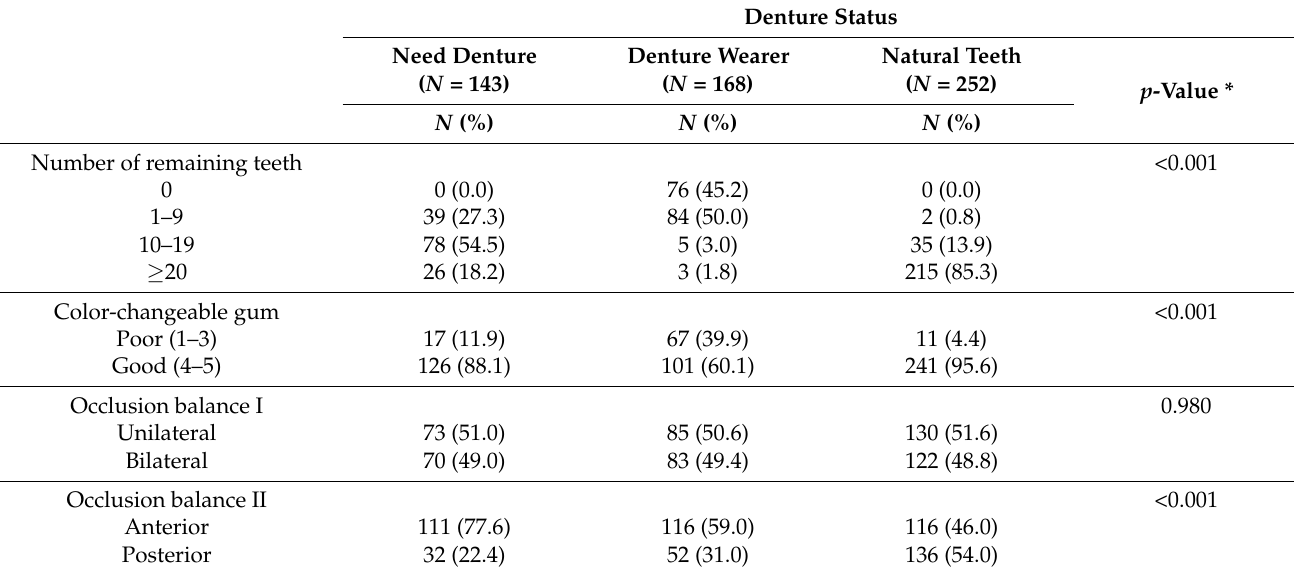
Table 2. Chewing ability according to denture